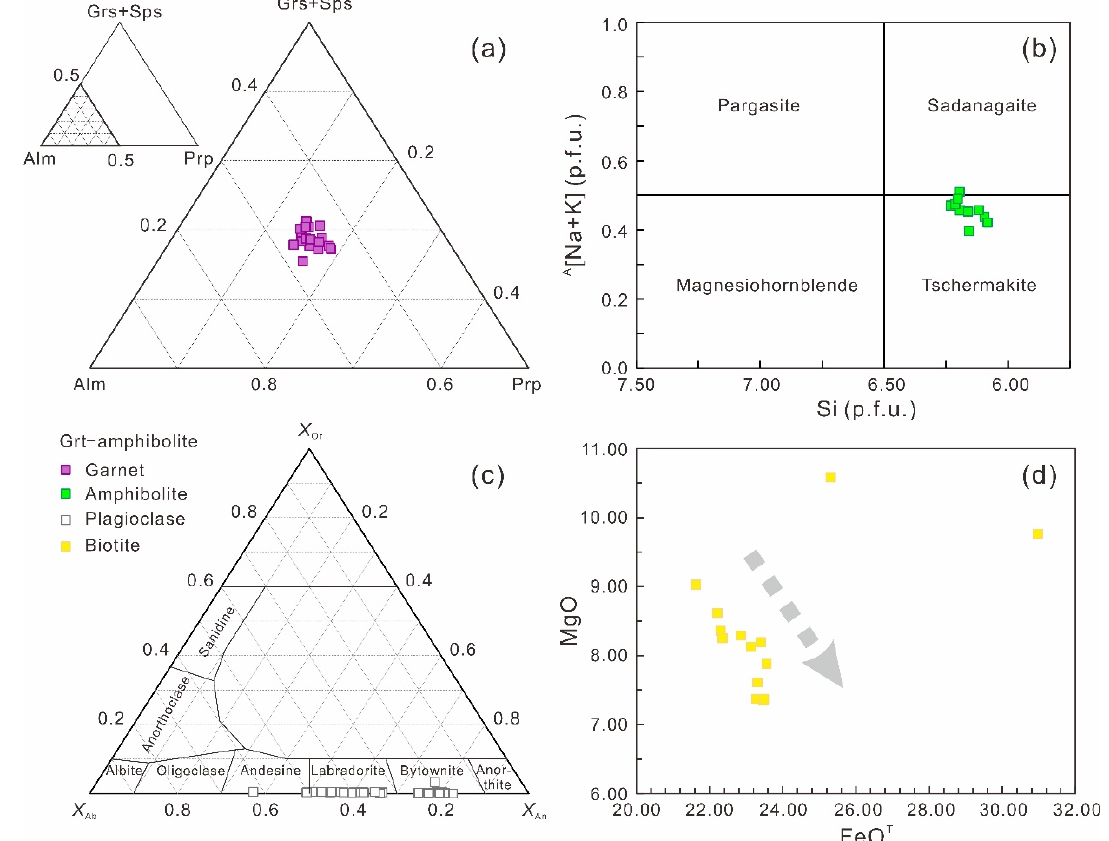
Figure 3. Compositional variation of Principal minerals from Grt-amphibolite from the JASB. ( a ) Alm vs. Prp vs. Grs + Sps ternary diagrams of garnet from Grt-amphibolite. ( b ) Si vs. A [Na+K] classification diagram for amphibole [80]. ( c ) X Ab vs. X An vs. X or classification diagram for plagioclase. ( d ) FeO T vs. MgO diagram for biotite.